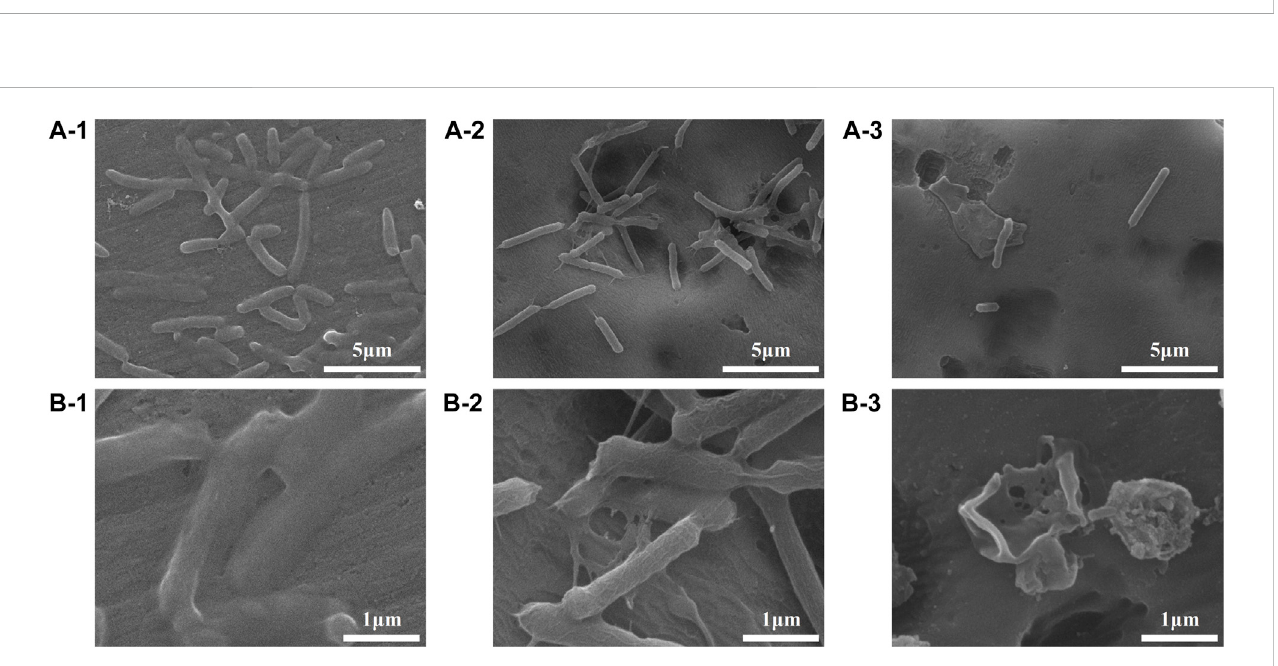
FIGURE 6 FESEMimagesshowingtheadhesionbehavioursof E.coli ontheAlspecimens(1),Al-COOHspecimens(2),andAl-peptidespecimens(3)with5000× (A) and ×20,000 magni fi cation (B)